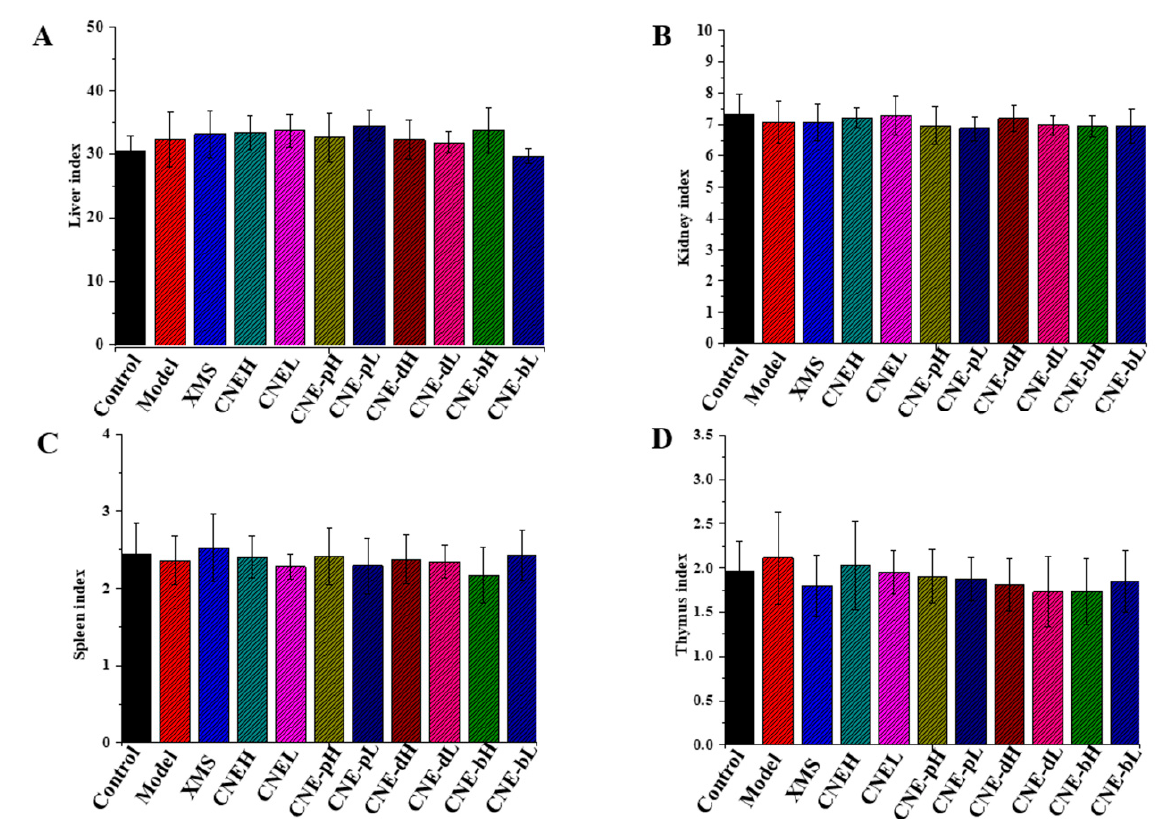
Figure 6. Organ index changes of SD rats treated with different extracts of C. nudiflora . ( A ) Liver. ( B ) Kidney. ( C ) Spleen. ( D ) Thymus.